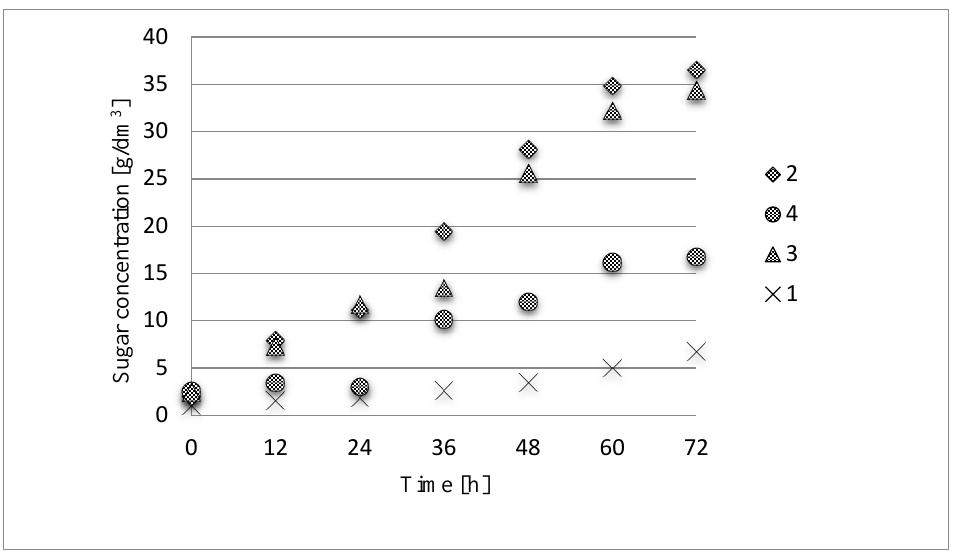
Figure 1. The concentration of sugars obtained after the enzymatic hydrolysis process of triticale straw: 1—control sample, without pretreatment; 2—after pretreatment with ionic liquid; 3—after chemical pretreatment (sulfate method); 4—after pretreatment using recycled ionic liquid.